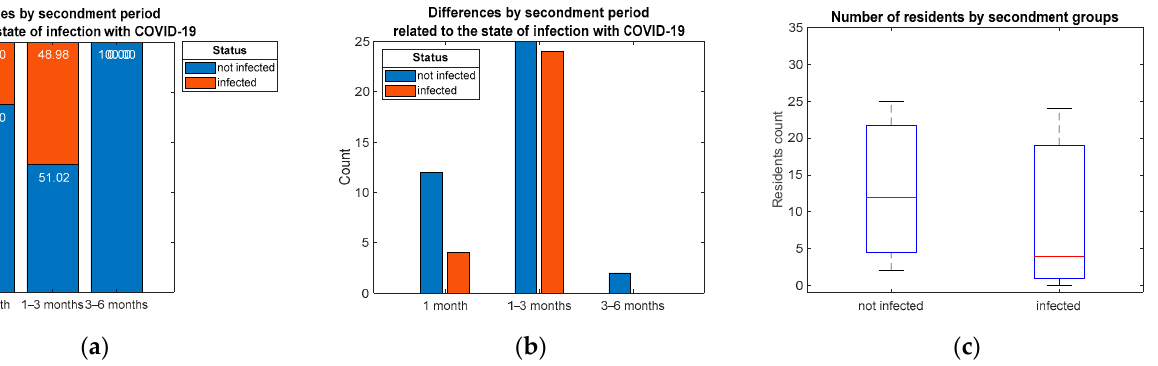
Figure 9. Distribution of respondents by: ( a ) percentage, ( b , c ) count considering differentiation by secondment period groups.